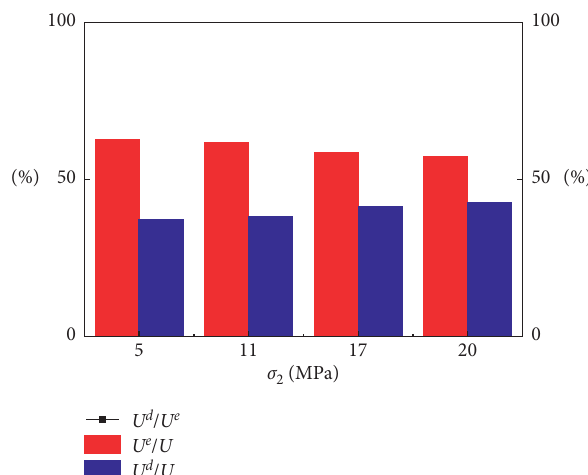
Figure 9: Failure point energy distribution under the unloading σ